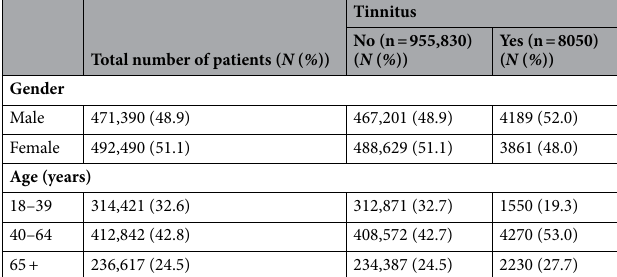
Table 1. Gender, age and number of referrals of patients with and without